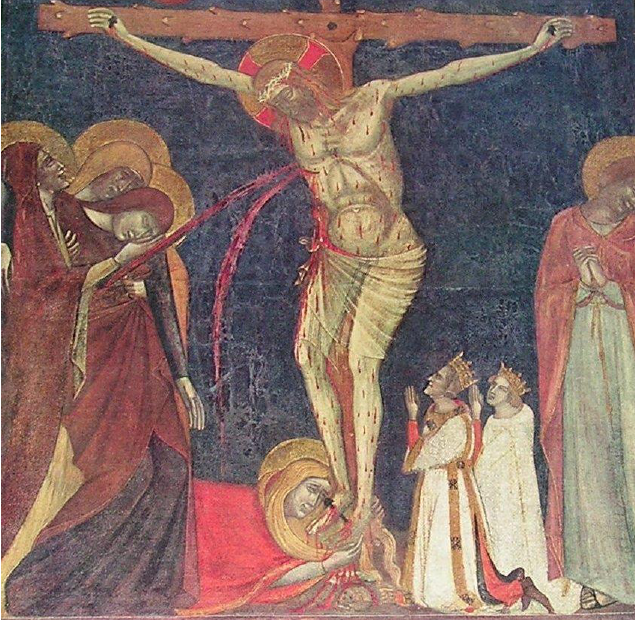
Figure 4. Master of the Franciscan tempera, Crucified Christ worshipped by Robert of Anjou and Sancia of Majorca , tempera on canvas, 1331–1336. Private collection. Image published in [12] (Figure